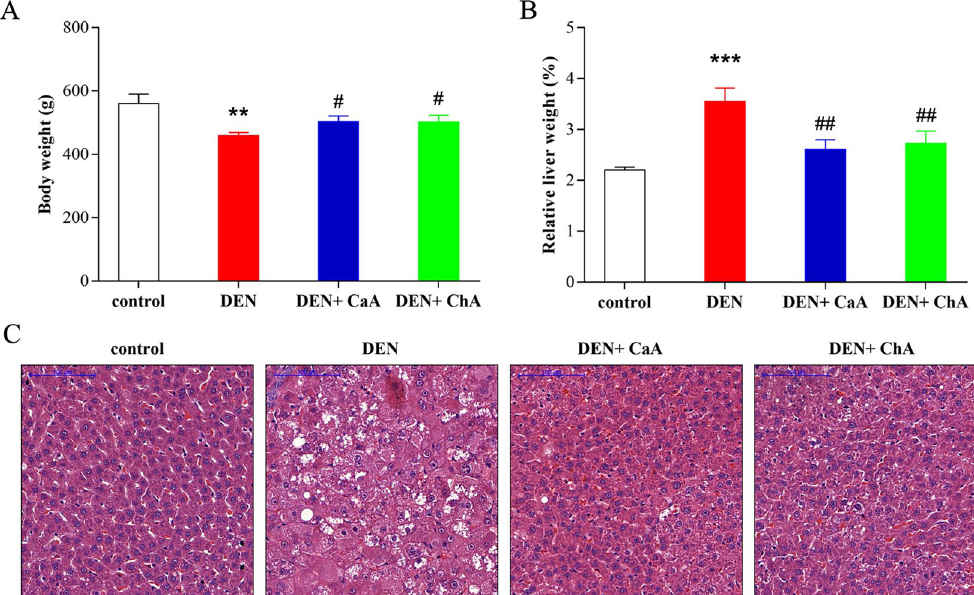
Figure 2. CaA and ChA improved DEN induced HCC in rats. ( A ) Body weight, relative and ( B ) relative liver weight were expressed as mean ± SD of 6 rats in each group. ** P < 0.01, *** P < 0.001 compared with control group; # P < 0.05, ## P < 0.01 compared with DEN group. ( C ) Representative images of the liver tissues from control, DEN, DEN + CaA and DEN + ChA group. Formalin fixed, paraffin-embedded 5 μ m cross-sections were stained with H&E. Scale bar: 100 μ